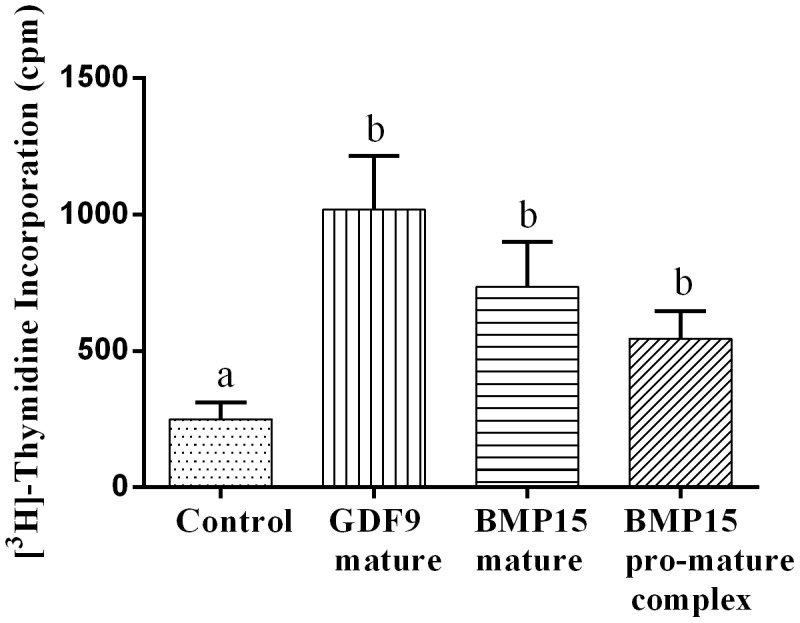
Bioactivity of different BMP15 and GDF9 forms.Granulosa cell tritiated thymidine incorporation following exposure to mature GDF9, mature BMP15 or pro-mature BMP15 at 100 ng/ml. Bars represent mean ± SEM and different lowercase letters indicate a statistically significant difference (P<0.05). Data were derived from 5 independent replicates.